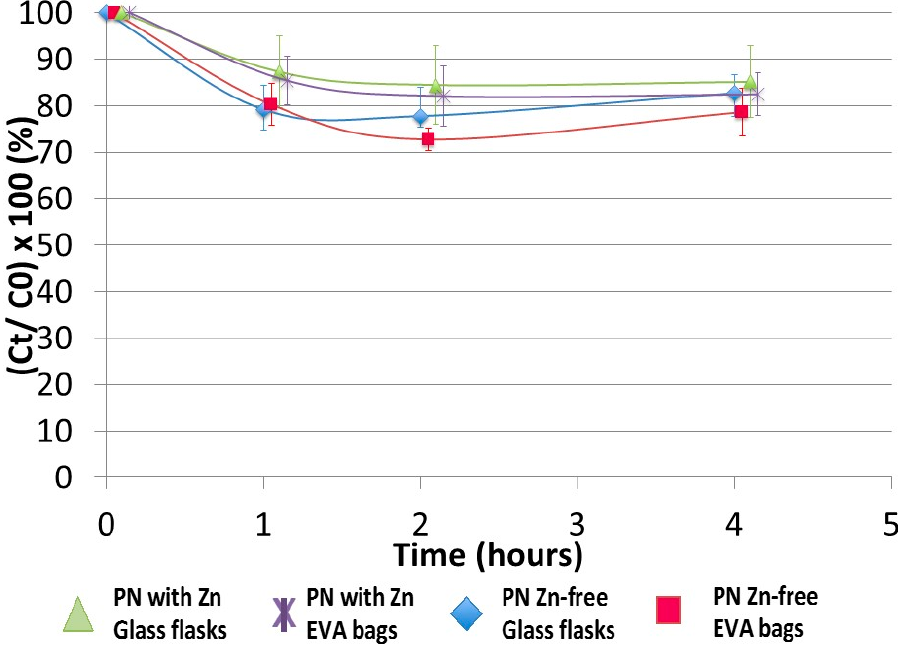
Figure 4. Impact of presence or absence of zinc in ternary PN admixture on insulin concentration. Zinc has no impact on insulin stability in ternary PN admixture.